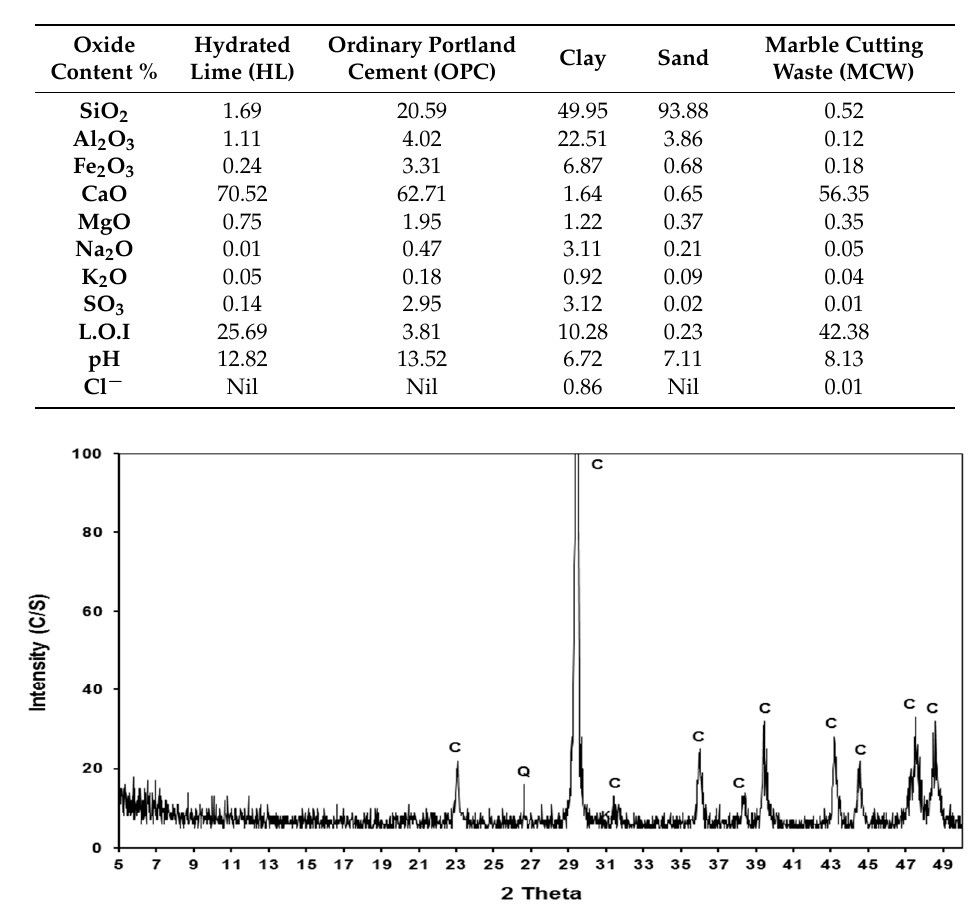
Table 2. Chemical compositions in terms of oxide content (wt.%), loss on ignition (LOI), and pH of the raw used materials.